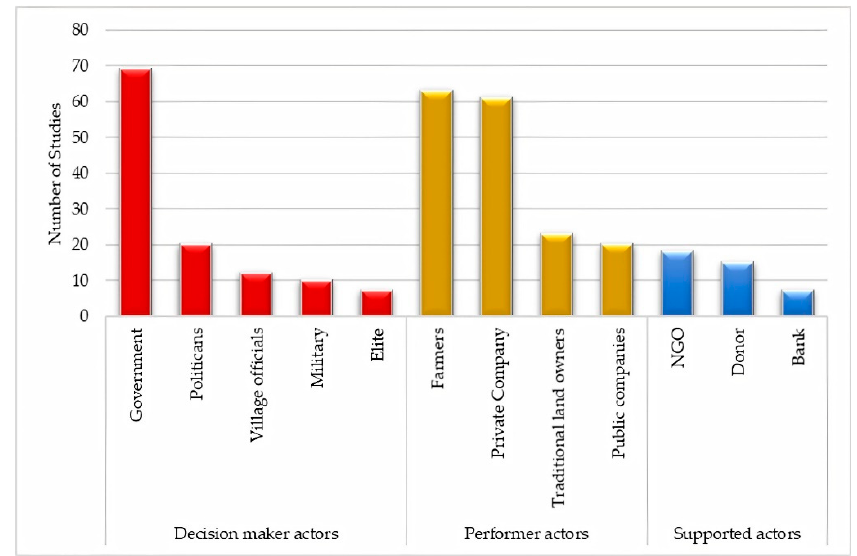
Figure 8. Diagram of land change actors in Sumatra and Kalimantan.